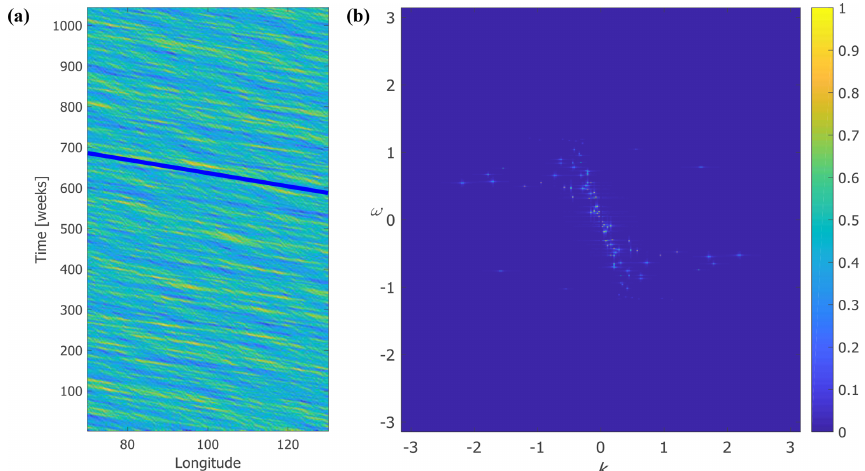
Figure 1. (a) An example of an artificial observed signal. (b) The associated ( ω , k ) diagram obtained by applying 2-D FFT to the signal of panel (a) . The solid blue line in panel (a) corresponds to the randomly chosen dominant input mode’s propagation speed.